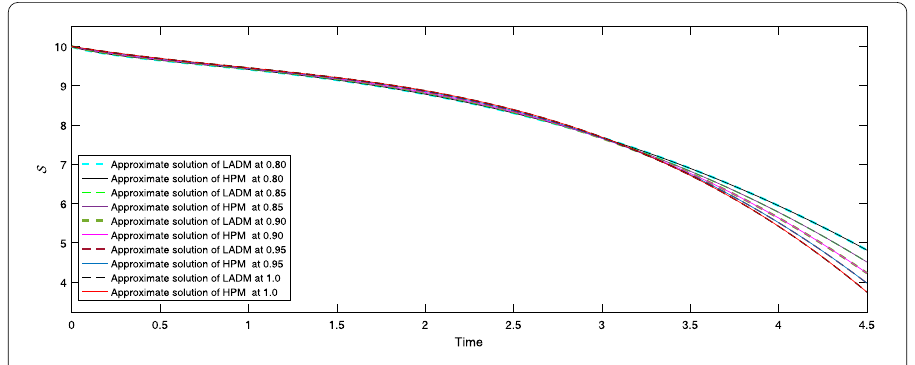
Figure 1 Comparison between the approximate solutions for S of model (3) for various fractional orders up to first three terms